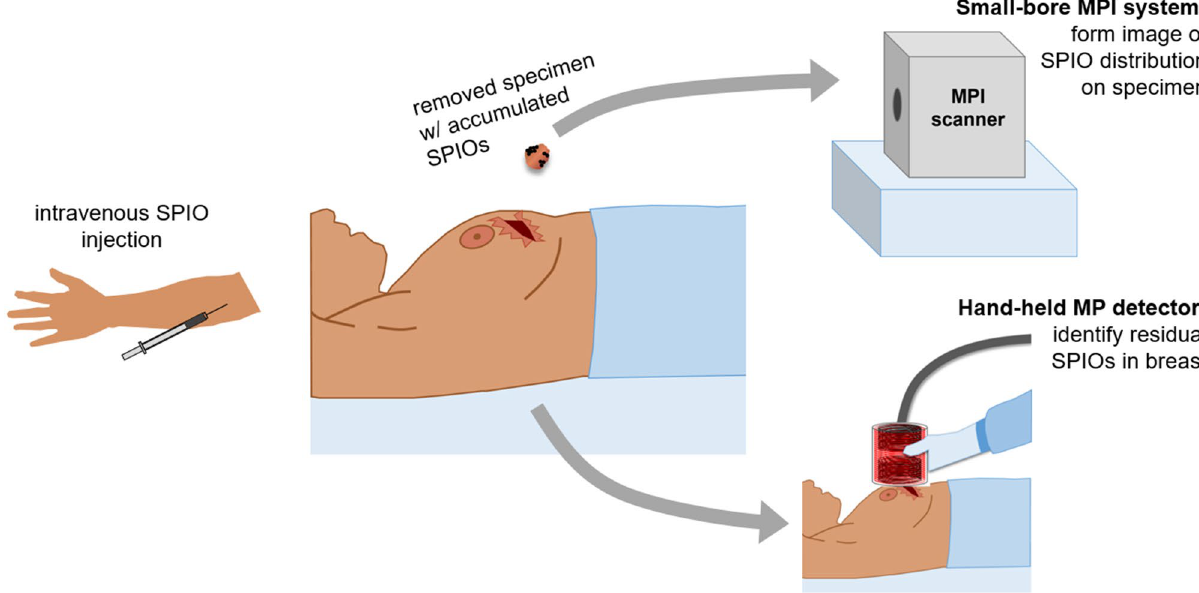
Figure 2. Envisioned MPI workflow during breast-conserving surgery. SPIOs would be injected intravenously prior to surgery with sufficient time for the nanoparticles to accumulate at the tumor and the background